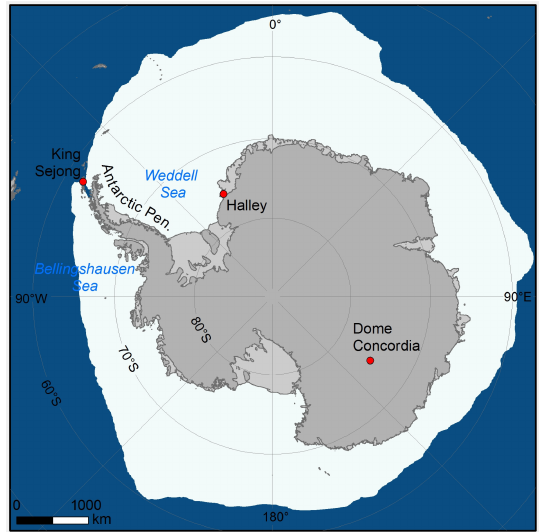
Figure 7. Map with locations of Antarctic monitoring stations con- sidered in Fig. 6. Please note that the sea ice extent is the median September extent from 1981 to 2010 (data are from the National Snow and Ice Data Center – NSIDC – at https://nsidc.org/data/ g02135, last access: 10 April 2020, Fetterer et al.,